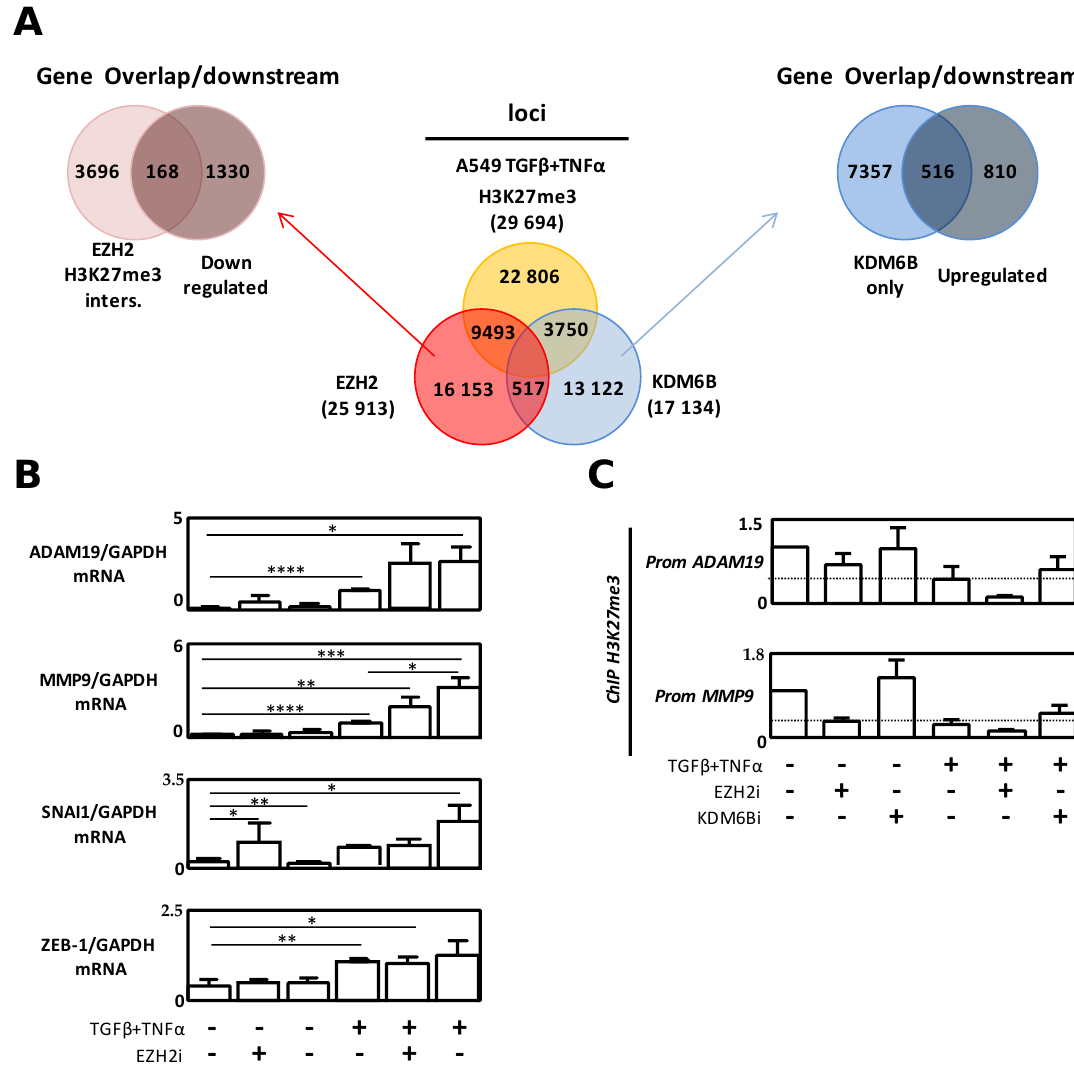
Figure 4. EZH2 and KDM6B regulated di ff erent genes during EMT. ( A ) Middle: Venn diagrams showing common and di ff erent DNA loci occupied by H3K27me3, EZH2, and KDM6B, and obtained following ChIP-seq experiments in A549 cells treated with TGF β / TNF α . Left: A Venn diagram showing the intersection between genes co-occupied by H3K27me3 and EZH2 and down-regulated genes. Right: A Venn diagram showing the intersection between genes occupied by KDM6B alone and up-regulated genes. ( B ) Quantification of ADAM19, MMP9, SNAI-1 , and ZEB-1 expression levels using RT-qPCR in A549 cells treated with TGF β / TNF α and / or EZH2i or KDM6Bi. ( C ) Quantification of the H3K27me3 content on ADAM19 , MMP9 using ChIP in A549 cells treated with TGF β / TNF α and / or EZH2i or TGF β / TNF α and / or KDM6Bi, respectively. * = 0.01 < p < 0.05; ** = 0.005 < p < 0.01; *** = 0.001 < p < 0.005; **** = p <